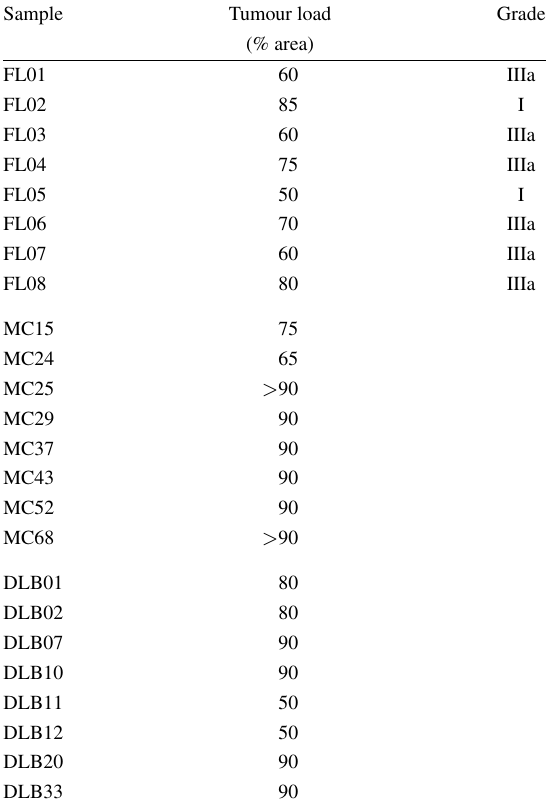
Tumour load of NHL cases in the proteomics study. The tumour load was assessed using adjacent H&E stained sections, and was ex- pressed as the relative area of the whole